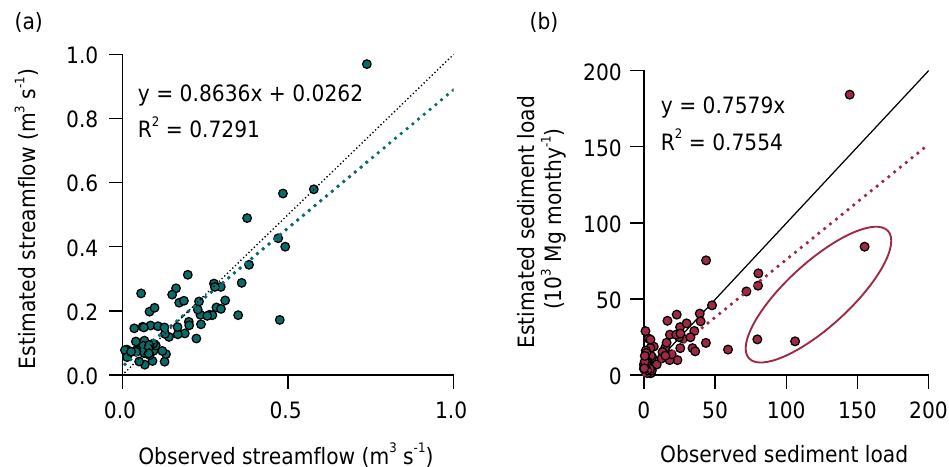
Figure 5. Observed and simulated monthly streamflow discharge (a) and sediment load (b) from Jan 2009 to Dec 2014. Circles highlight the points in which there was greater underestimation from the model